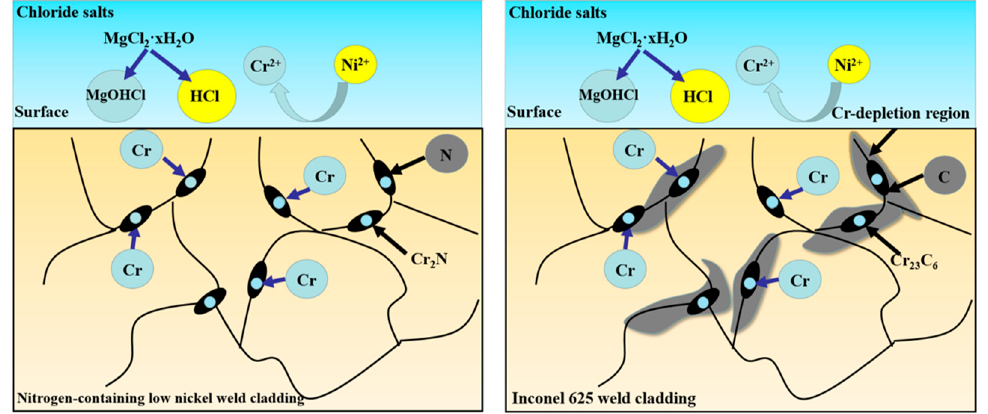
Figure 12. Action and corrosion mechanism of the element